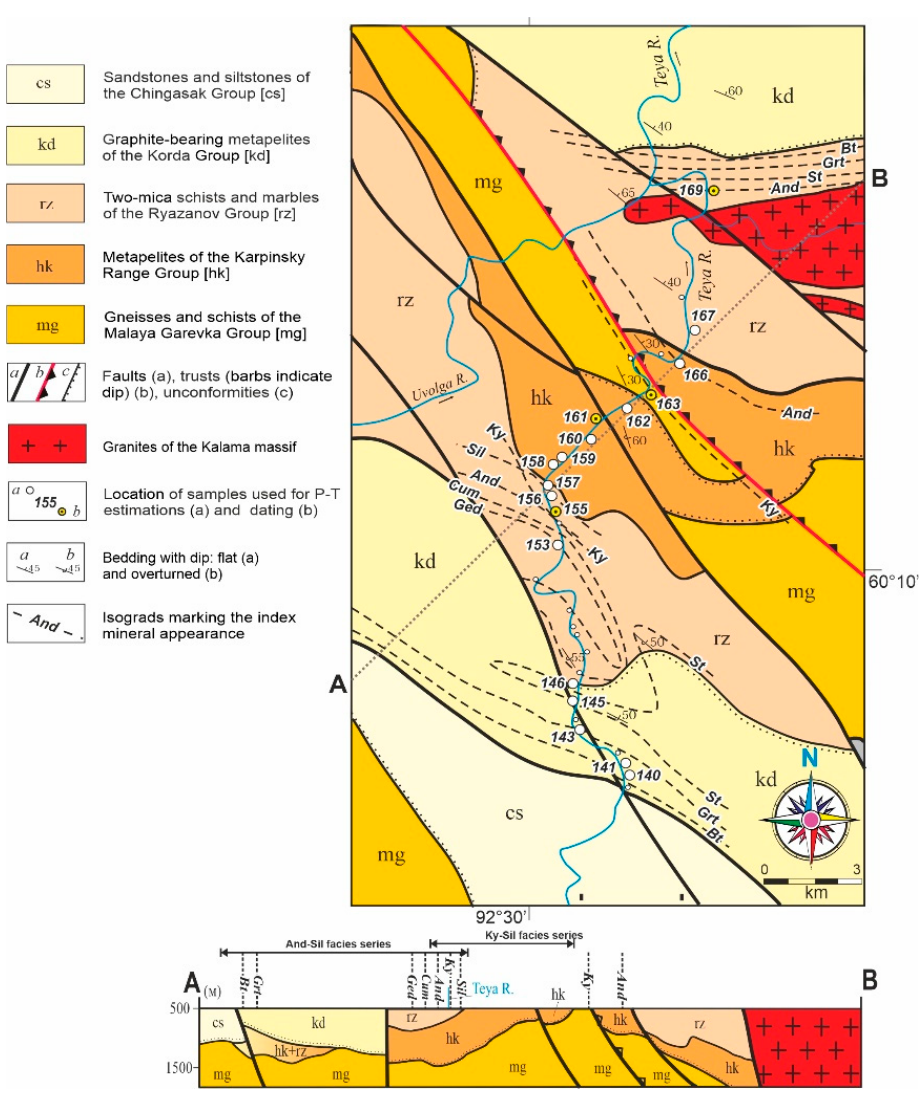
Figure 10. Sketch map of the Teya polymetamorphic complex in the middle reaches of the Teya River (Teya area) and geological cross-section through the A–B line.